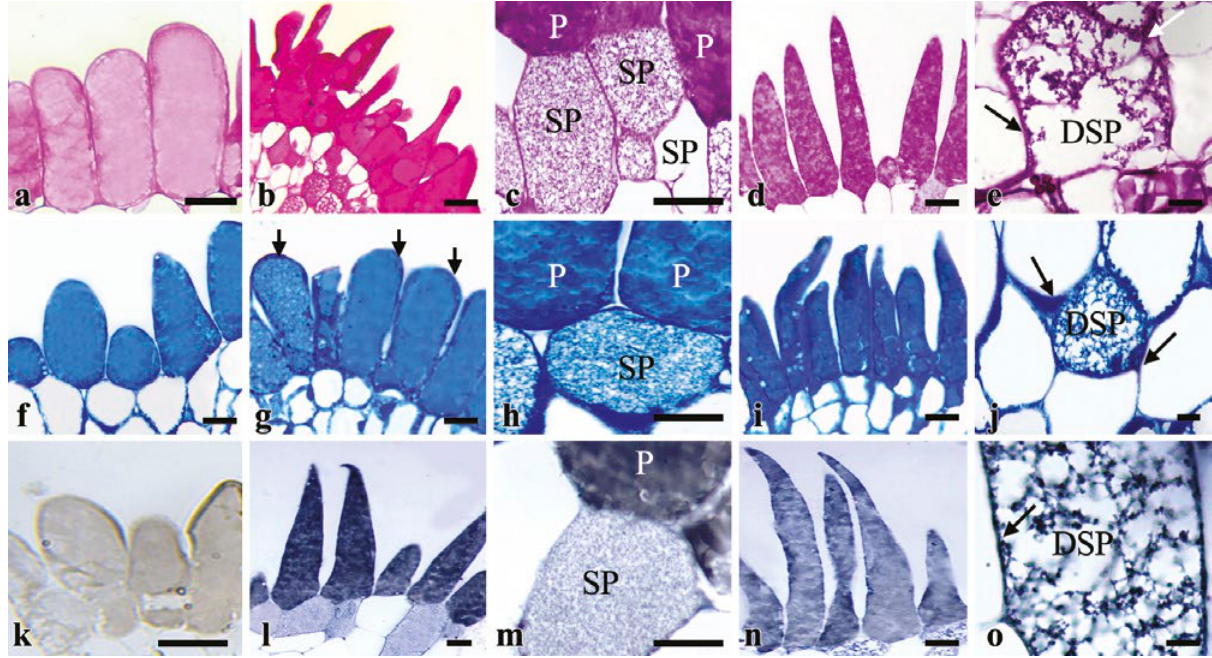
Figure 2. Semi-thin longitudinal sections of stigma of Hibiscus syriacus stained by PAS (a-e), CBB (f-j) and SBB (k-l). Short and ovoid papillae cells at anthesis (a, f, k). Papillae cells with dense organic material content and prominent pellicle layer (arrows) at anthesis (b, g, l). Sub-papillary cells that accumulate a large amount of organic material (c, h, m). Thorn shaped papillae with dense cytoplasm at post- anthesis (d, i, n). Degenerated subpapillary cells and their diffused contents to intercellular space (arrows) (e, j, o). P: Papillae cell, SP: Sub- papillary cell, DSP: Degenerated sub-papillary cell. Scale: 20